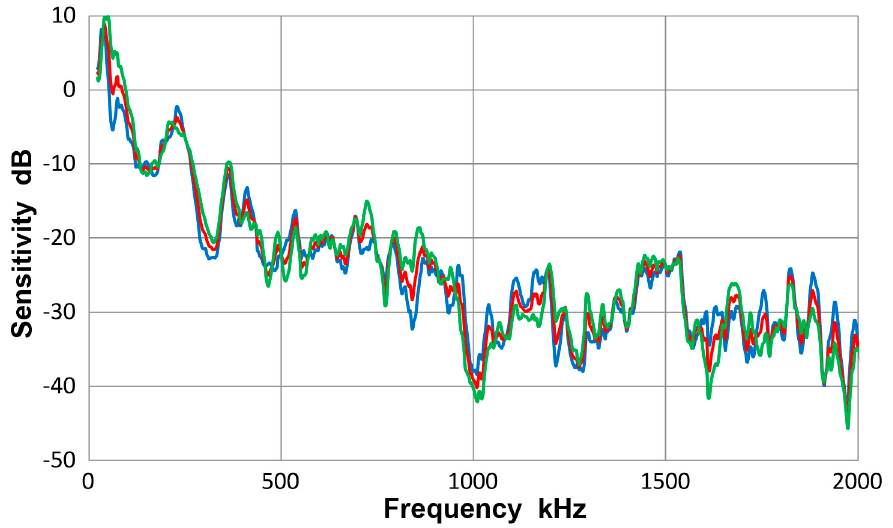
Figure 13. Receiving sensitivity of DECI SH225 sensor. Red -averaged guided wave sensitivity, blue - Lamb waves for 12.7 and 6.4 mm plates, green -bar waves for 12.7 and 6.4 mm bars. blue -Lamb waves for 12.7 and 6.4 mm plates, green -bar waves for 12.7 and 6.4 mm